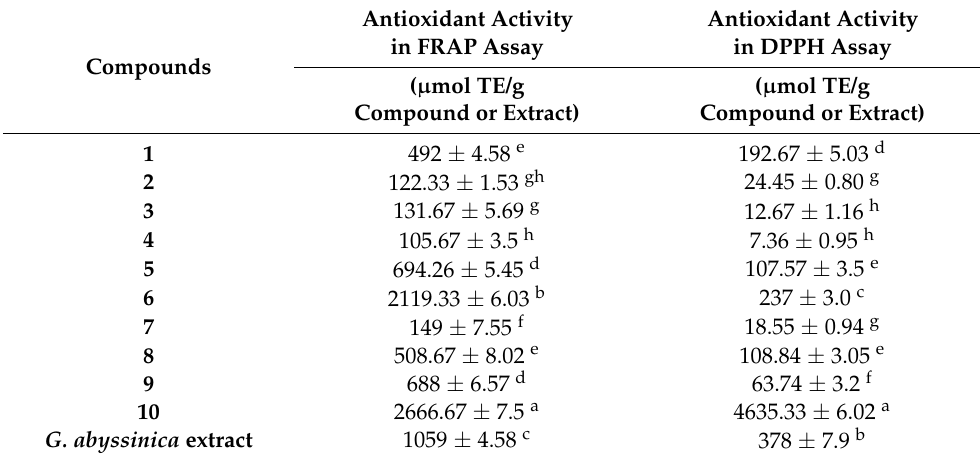
1059 ± 4.58 c 378 ± 7.9